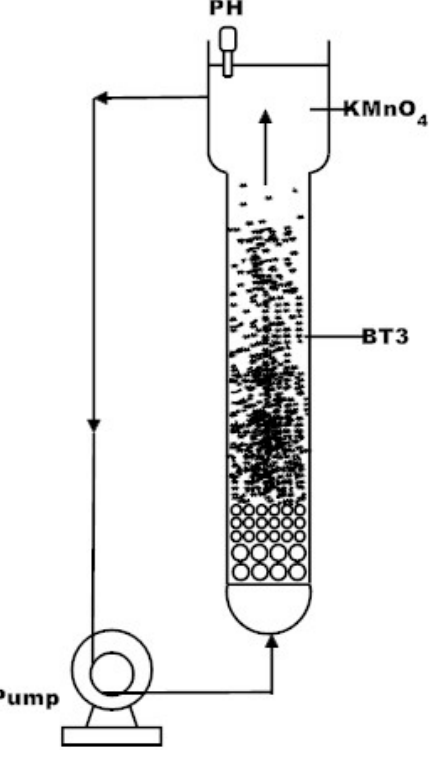
Figure 1. Fluidized bed